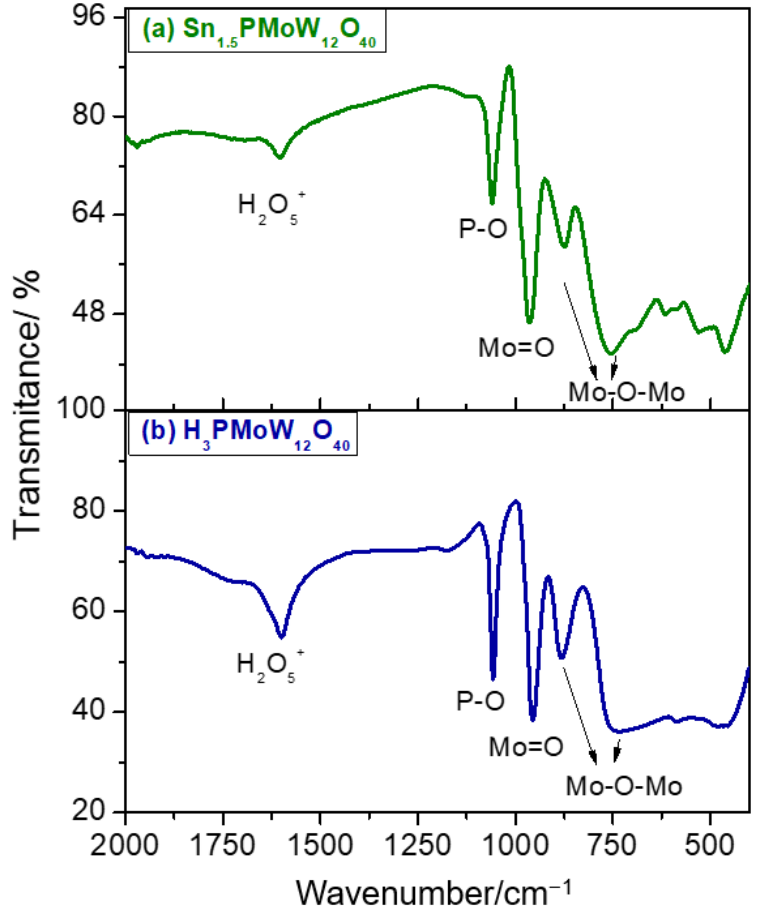
Figure 4. FTIR spectra of ( a ) Sn 1.5 PMo 12 O 40 and ( b ) its precursor H 3 PMo 12 O 40.